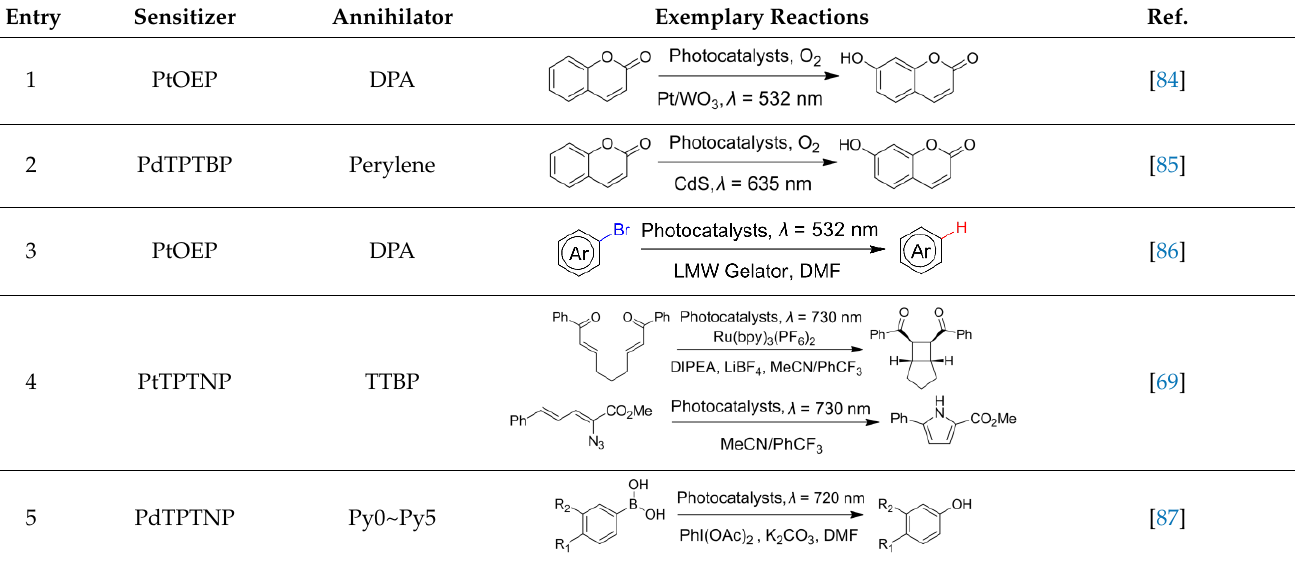
Table 1. Summarized photoinduced organic synthesis reactions of porphyrin-based TTA-UC. Exemplary Reactions